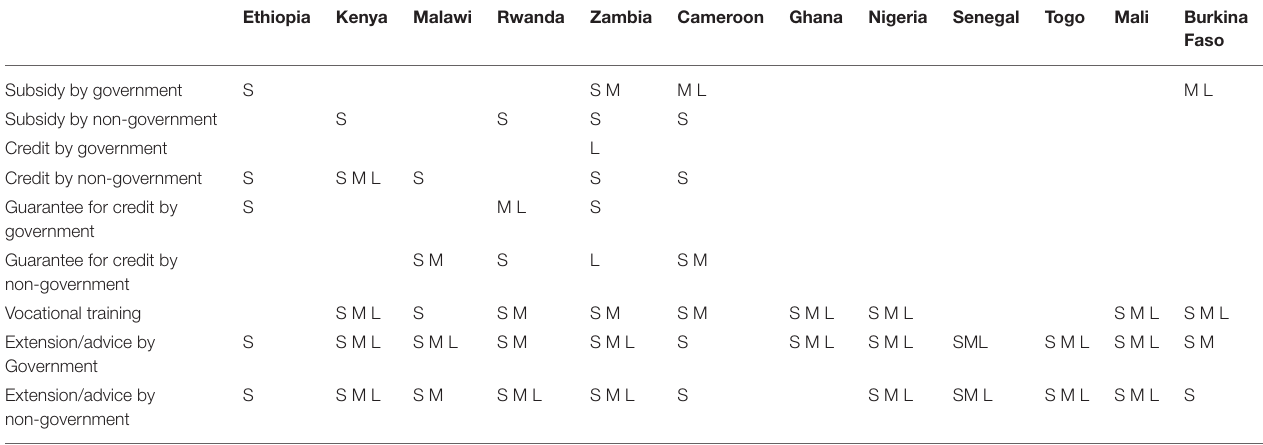
TABLE 2 | Availability of services that enable the adoption of improved manure management practices to small, medium, and large farmers in selected sub-Saharan African